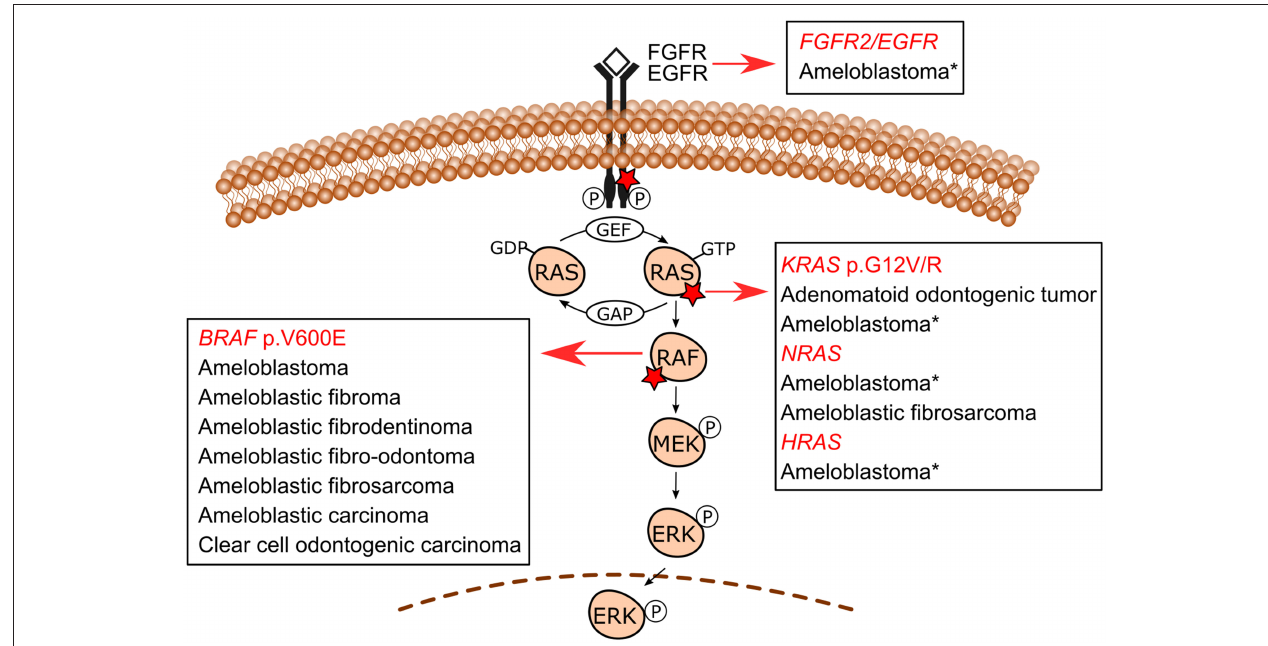
FIGURE 2 | MAPK/ERK signaling pathway mutations in odontogenic tumors. BRAF p.V600E is the most common mutation in ameloblastomas, followed by KRAS (mostly p.G12R), NRAS , HRAS , and FGFR2 mutations reported in a few BRAF wild-type cases. Additionally, an EGFR mutation has also been reported in one ameloblastoma case. These less commonly reported mutations in ameloblastomas are indicated with an asterisk (*). Ameloblastic fibromas, ameloblastic fibrodentinomas, ameloblastic fibro-odontomas, ameloblastic fibrosarcoma, ameloblastic carcinomas, and clear cell odontogenic carcinoma (a single case) also carry BRAF p.V600E mutation. An NRAS mutation has also been reported in one case of ameloblastic fibrosarcoma in a mutually exclusive manner with BRAF p.V600E. Adenomatoid odontogenic tumors are characterized by frequent KRAS codon 12 (either p.G12V or p.G12R, and in a single case p.G12D) driver mutations,